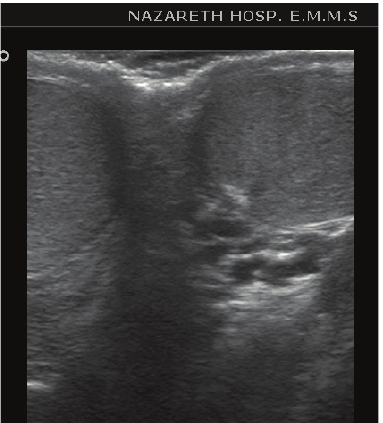
Figure 2: Transverse ultrasound of scrotum shows normal two testes in